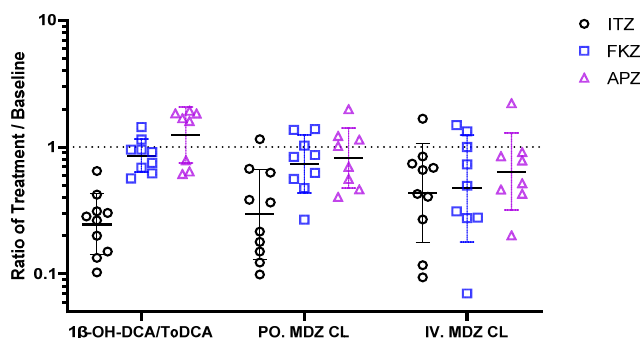
Figure 4. Comparison of the changes of 1 β -OH-DCA/ToDCA UMR, oral, and i.v. clearance of MDZ from baseline following the repeated administration of ITZ (100 mg od for 6 days), FKZ (50 mg od for 14 days), and APZ (1 mg od for 9 days).